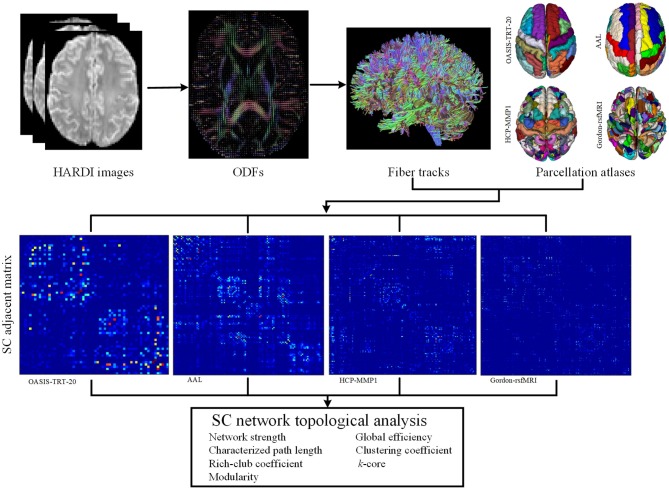
Flowchart of SC network topological analysis. Four parcellation atlases were employed to define the nodes of the SC networks, including OASIS-TRT-20 (62 regions) (Klein and Tourville, 2012), AAL (116 regions) (Tzourio-Mazoyer et al., 2002), HCP-MMP (180 regions) (Glasser et al., 2016), and Gordon-rsfMRI (333 regions) (Gordon et al., 2014). ODFs were computed from HARDI images with a general q-ball imaging (GQI) computational model. Whole-brain tractography was performed using the DSI-Studio tool, and edges were determined by the number of neural connections between each pair of parcellated regions.